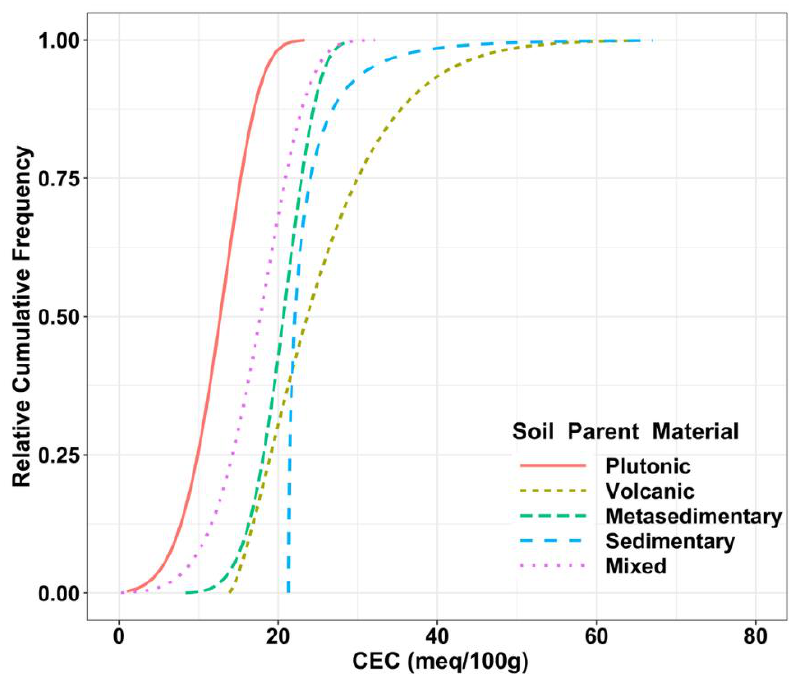
Figure 5. Soil exchangeable calcium cumulative distributions for different bedrock soil parent materials in the Inland Northwest, USA.